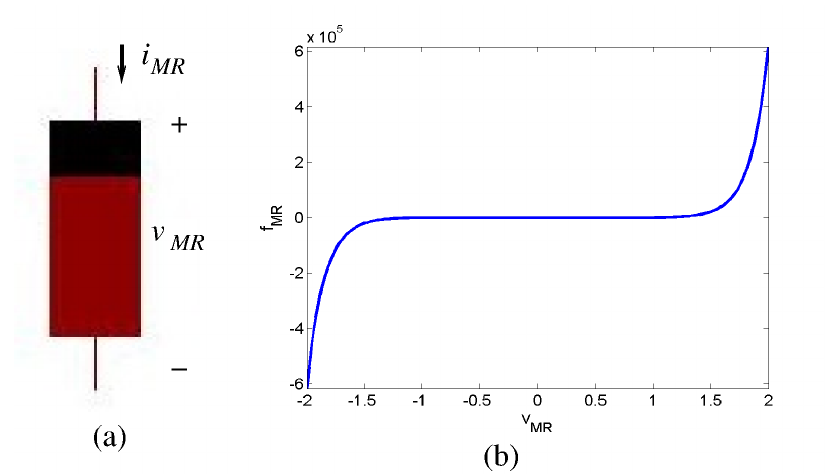
Figure 7. ( a ) Memristor symbol and ( b ) typical thresholded memristive adaptation